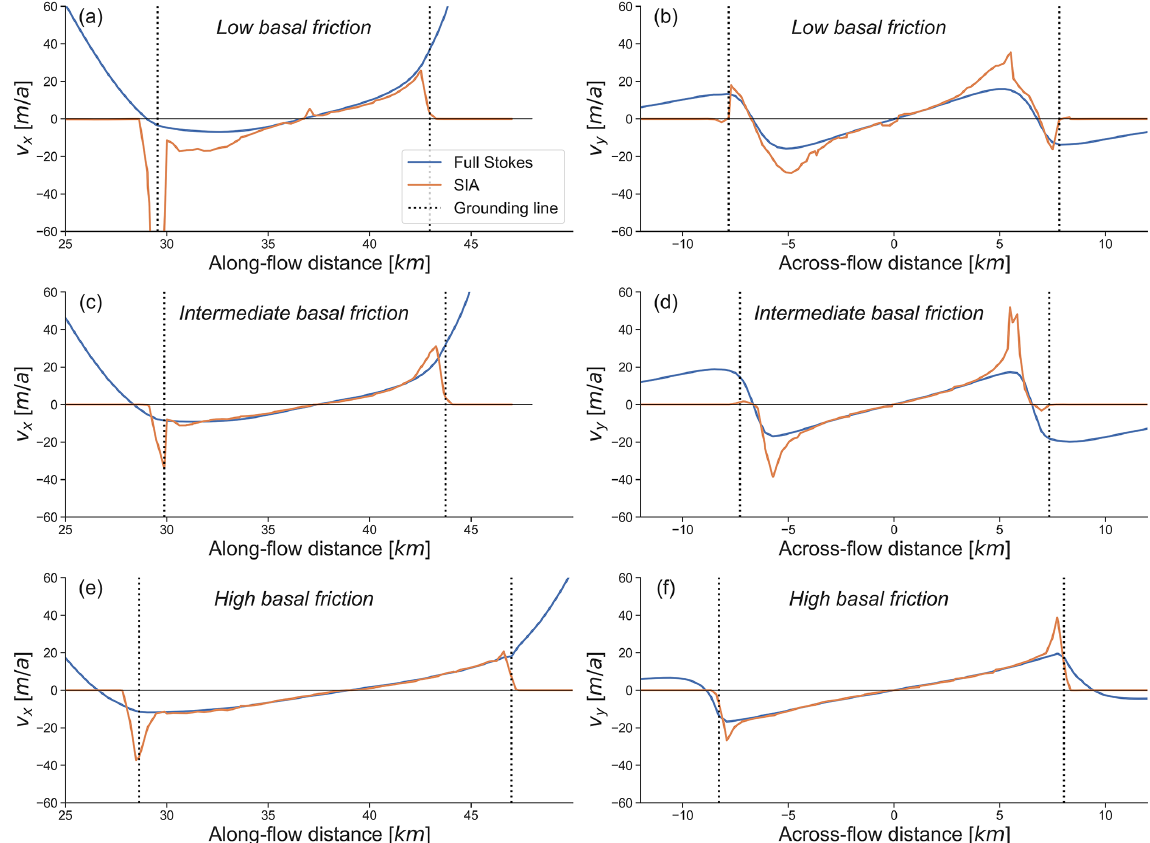
Figure 6. The full Stokes and SIA surface velocities at t = 2000 years in the along-flow direction ( a , c , and e ) and in the across-flow direction ( b , d , and f ), as indicated by the cross-sections A–A (cid:48) and B–B (cid:48) through the divide in Fig. 5. Panels (a) and (b) show the low-basal- friction scenario, (c) and (d) show the intermediate-basal-friction scenario, and (e) and (f) show the high-basal-friction scenario.